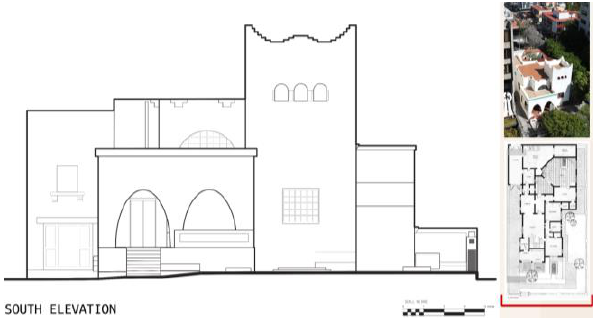
Fig. 11 South elevation of Casa Cristo in scale 1:50. Example of the 2- dimensional drawings produced.